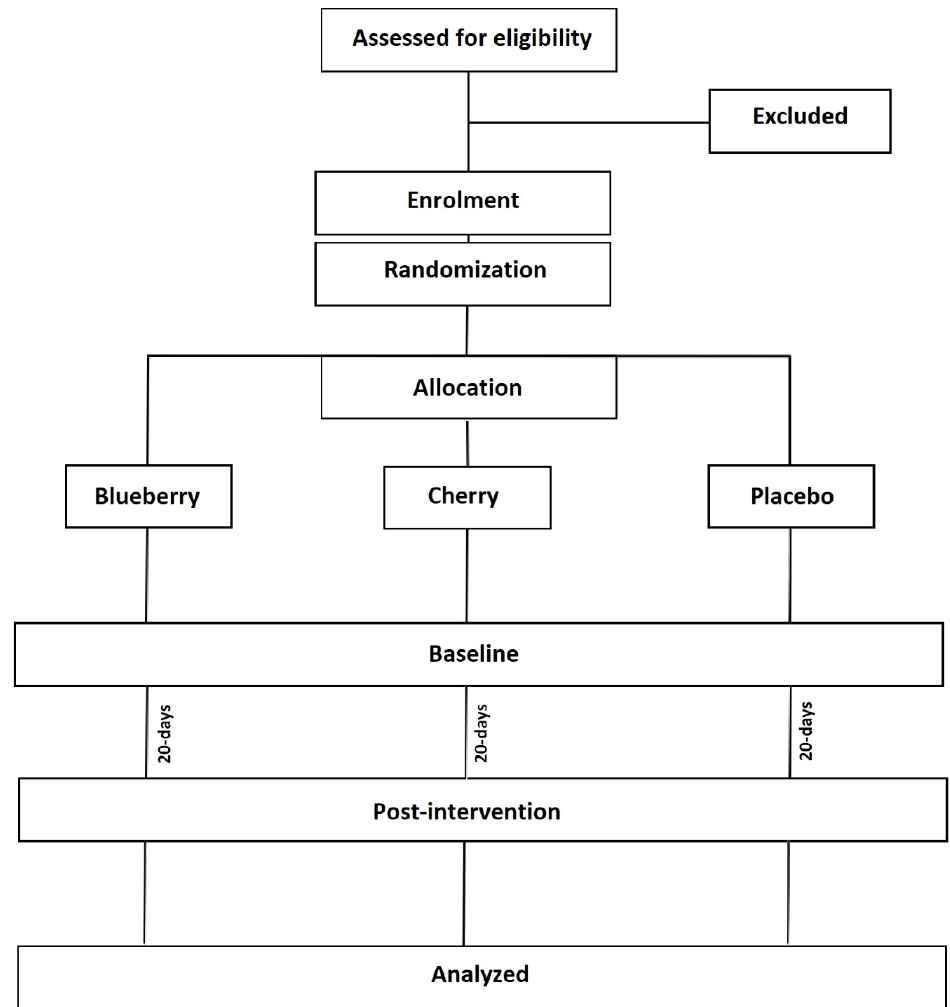
Figure 1. Consort diagram showing the study